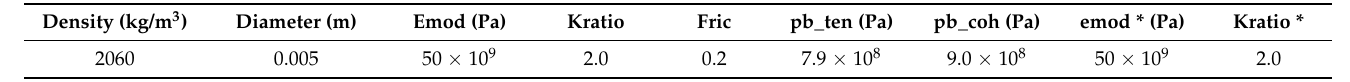
Figure 4. BFR mesh simulated by PFC3D. Table 3. Micro-parameters of BFR. Table 3. Micro ‐ parameters of BFR.